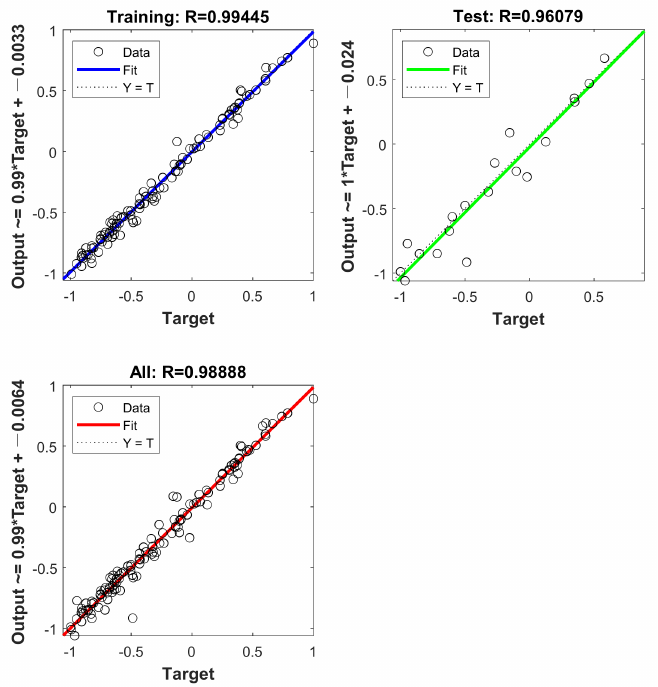
Figure 7. BR-ANN model fitting. Table 7. Evaluation metrics for training set and test